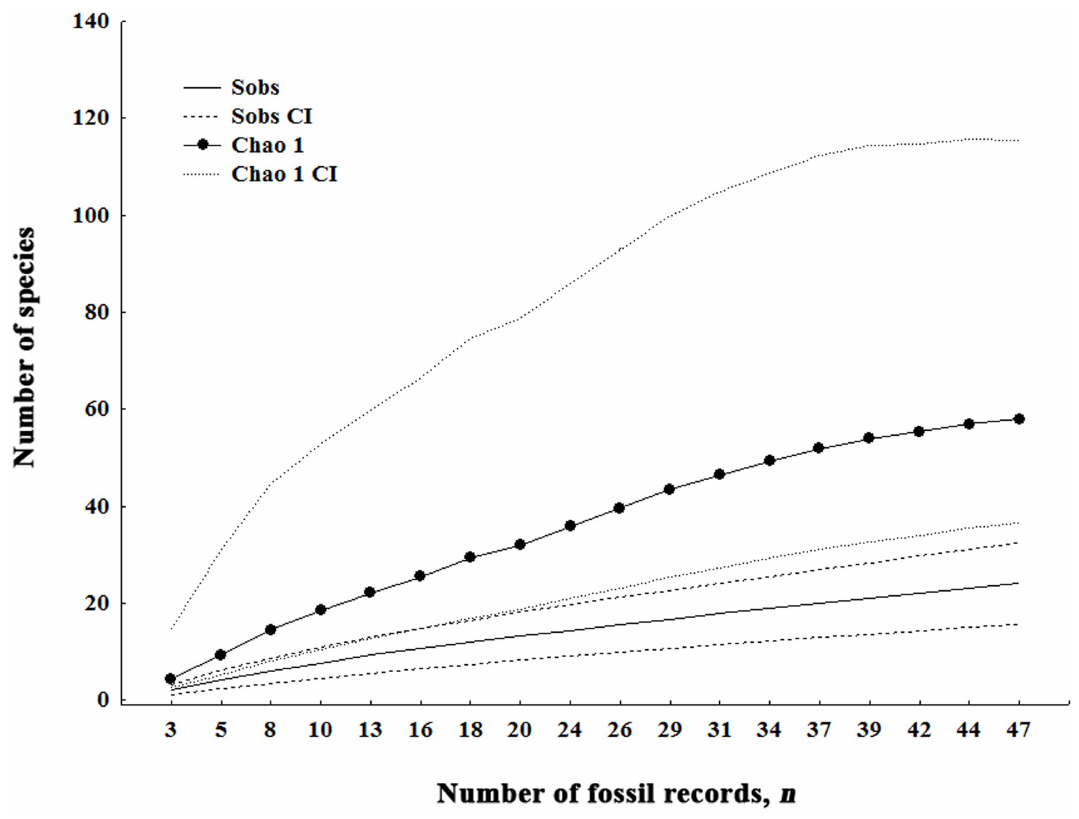
Figure 1. Estimates of species richness represented by rarefaction curves calculate with data of fossil records. The curves were generated from 1000 randomizations with replacement and the sampling units corresponding to the total of fossil record ( n ) in the stratigraphic formations of Late Cretaceous in South America (Campanian–Maastrichtian). Sobs: richness observed.